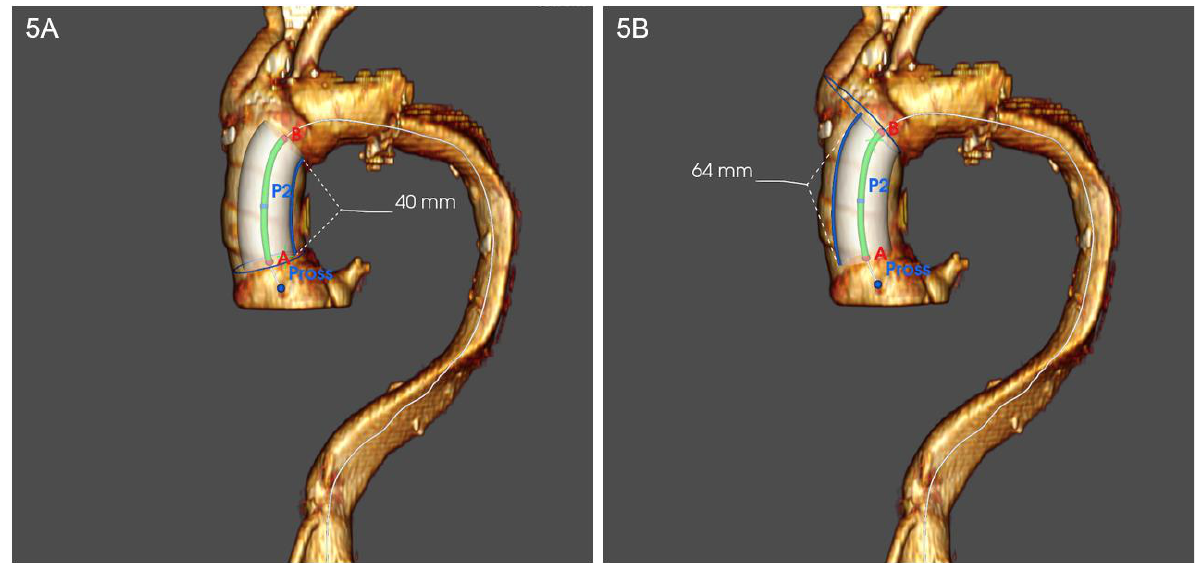
Figure 5. ( A , B ) Representation of inner and outer curves of ascending aorta in volume rendering 3D computed tomography angiogram. Inner curve ( A ) appears shorter than outer curve ( B ).